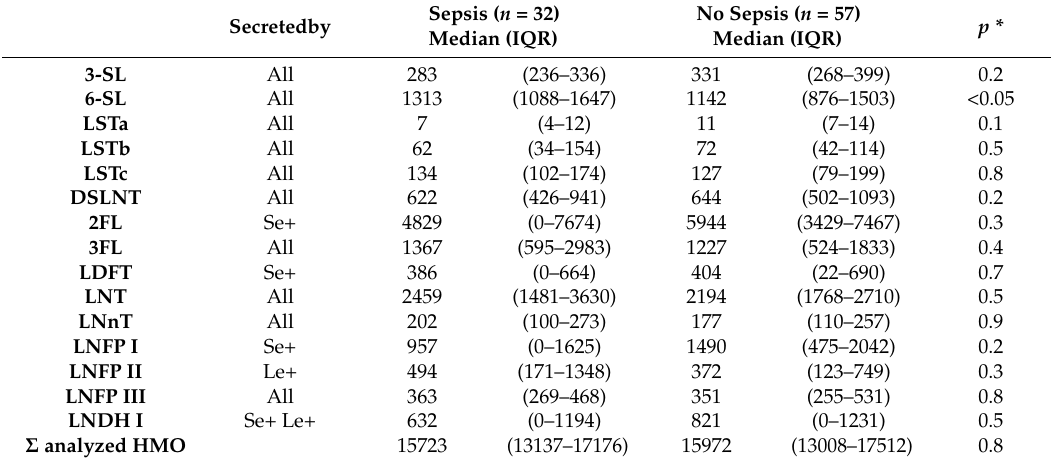
Table 4. Comparison of human milk oligosaccharide (HMO) concentrations ( µ mol/L) in milk samples from day 14 to infants who developed or did not develop culture-proven